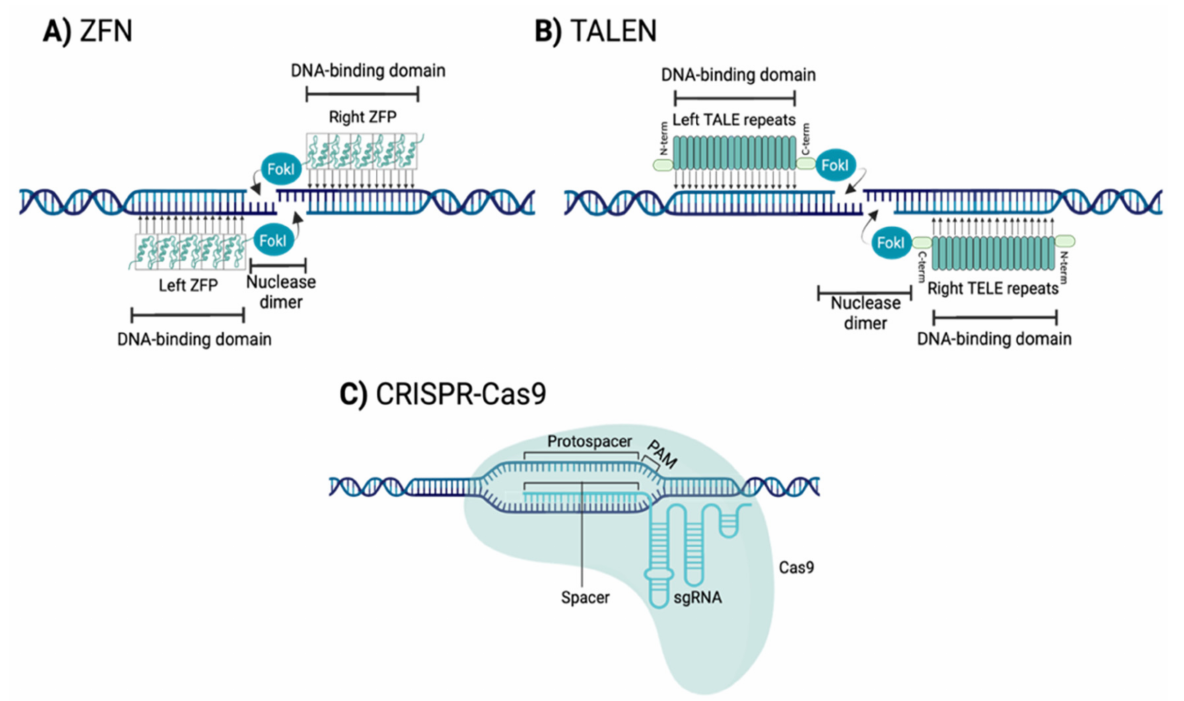
Figure 3. Site-specific nuclease systems. ( A ) Zinc-finger nucleases (ZFNs) recognize DNA target sequence using specific tandems of three base pair recognition motifs (ZFP). Paired ZFNs bind to the opposite strands to dimerize FokI, producing a DSB at the desired site; ( B ) transcription activator-like effector nucleases (TALENs) recognize the specific DNA sequence through TALE repeats that include repeat-variable di-residues (RVDs). TALE proteins contain an N-terminal region, a central domain of repeats and a C-terminal region. Paired TALENs bind to the opposite strands to dimerize FokI, producing a DSB at the desired site; ( C ) CRISPR-Cas9 recognizes the specific DNA sequence using a single guide RNA (sgRNA) and the Cas9 protein recognizes the protospacer adjacent motif (PAM) and cleaves the DNA at the target site, generating a